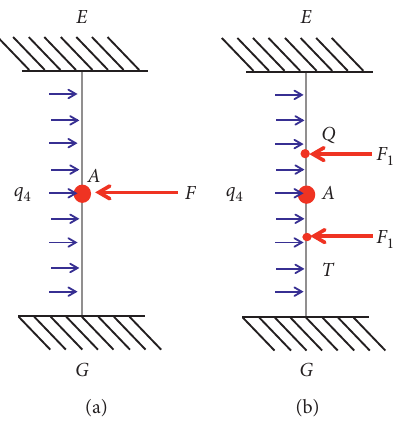
Figure 9: Schematic diagram of key control technology.